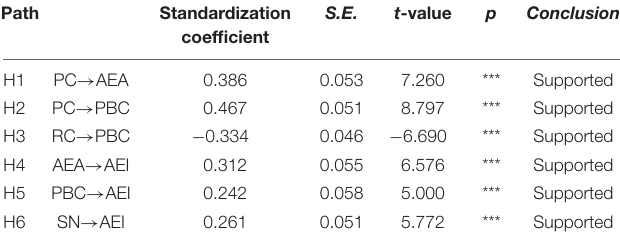
TABLE 6 | Hypothesis